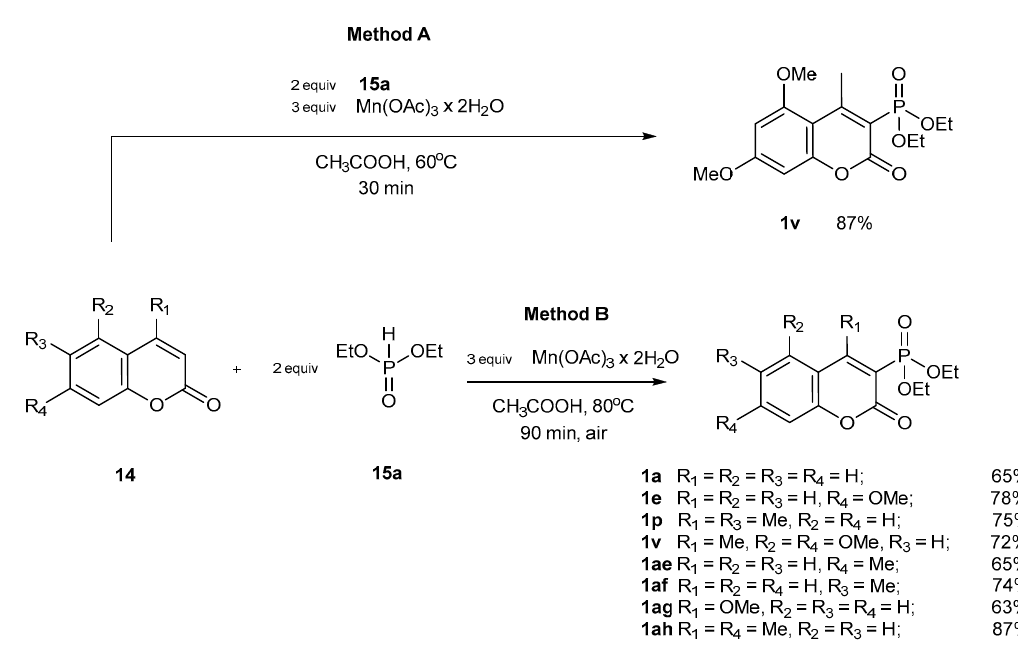
Table 2. Results from the reactions of 2-diethoxyphosphorylacrylates 12 with substituted phenols or naphthols 13 in the presence of strong